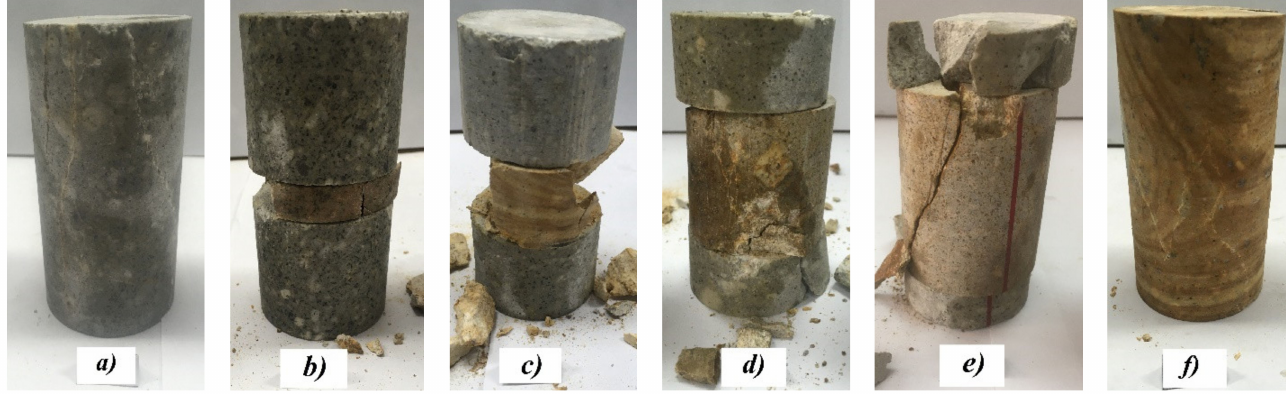
Figure 9. Specimens after testing—triaxial test: ( a ) 0% AD, ( b ) 10% AD, ( c ) 30% AD, ( d ) 50% AD, ( e ) 70% AD, ( f ) 100%